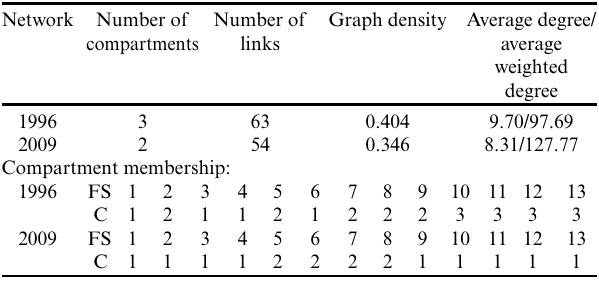
indicated by membership number 1 in Table 1 and yellow in the Fig.